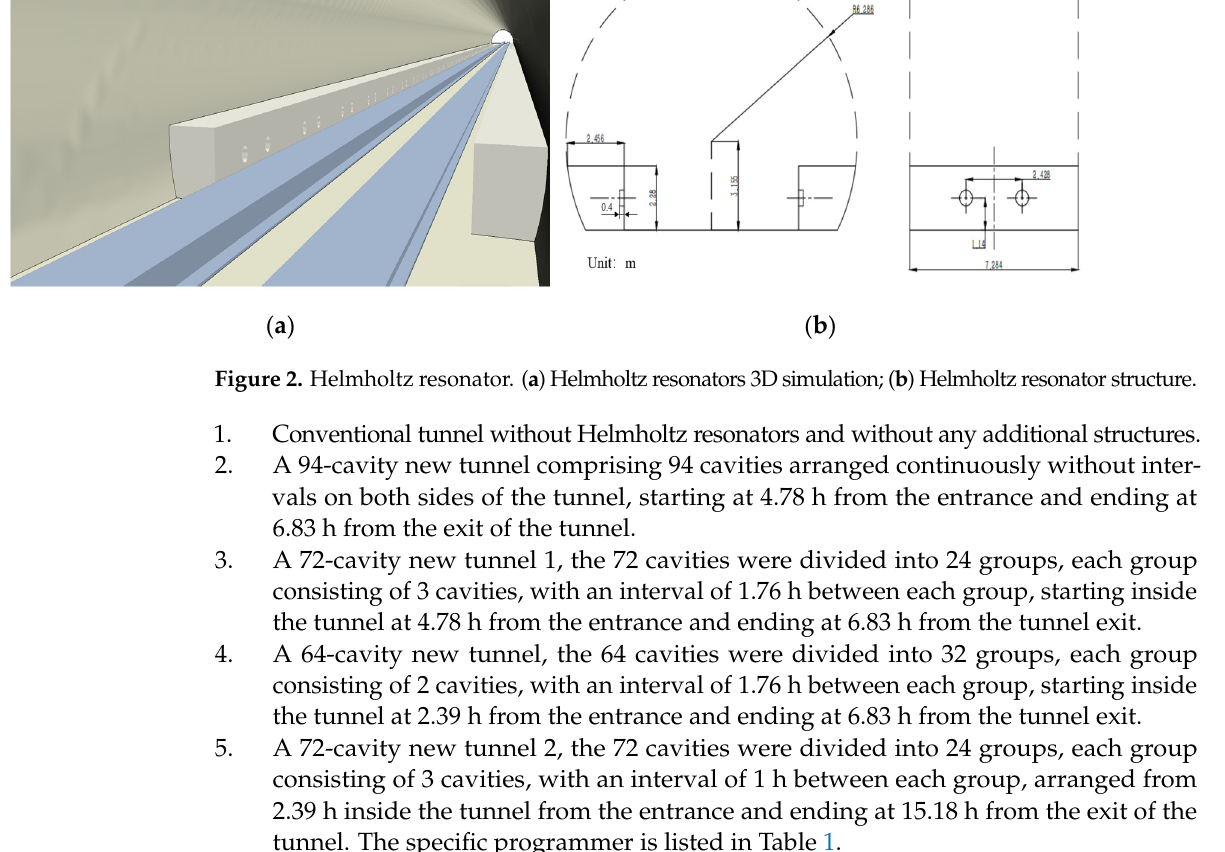
Figure 1. Maglev train model.